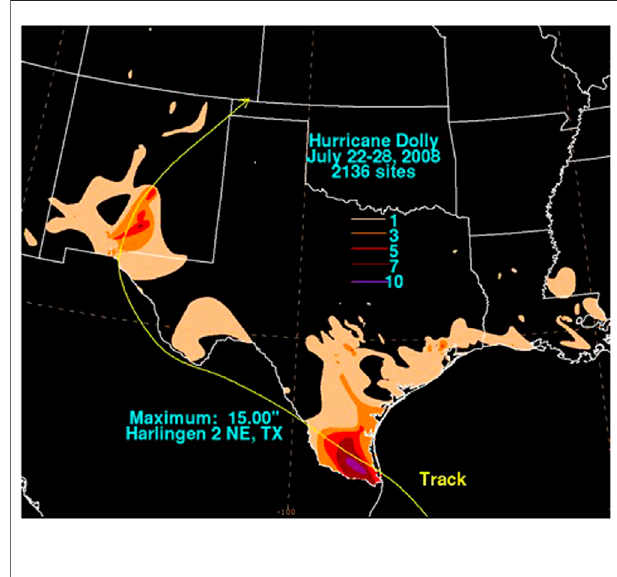
FIGURE 8 | Rainfall associated with Hurricane Dolly in inches. Source: NOAA/NWS (https://www.wpc.ncep.noaa.gov/tropical/rain/ dolly2008 fi